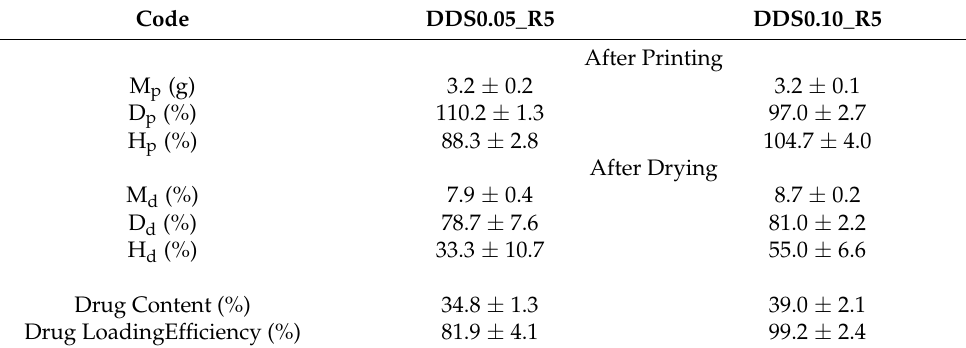
Table 1. Mass and dimensional analysis, after printing and drying; drug content and drug loading efficiency of RBZ-loaded DDS.